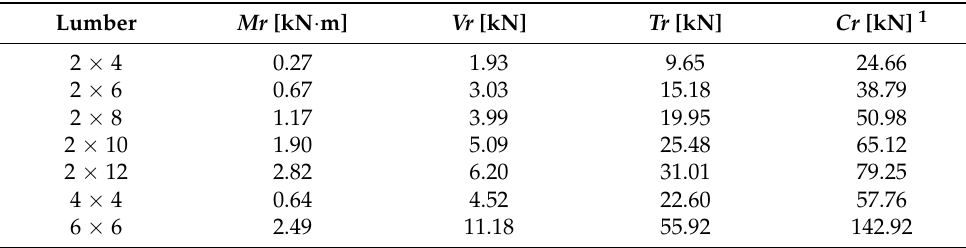
Table A7. Resisting values for No. 1/2 Spruce Pine Fir Lumber.